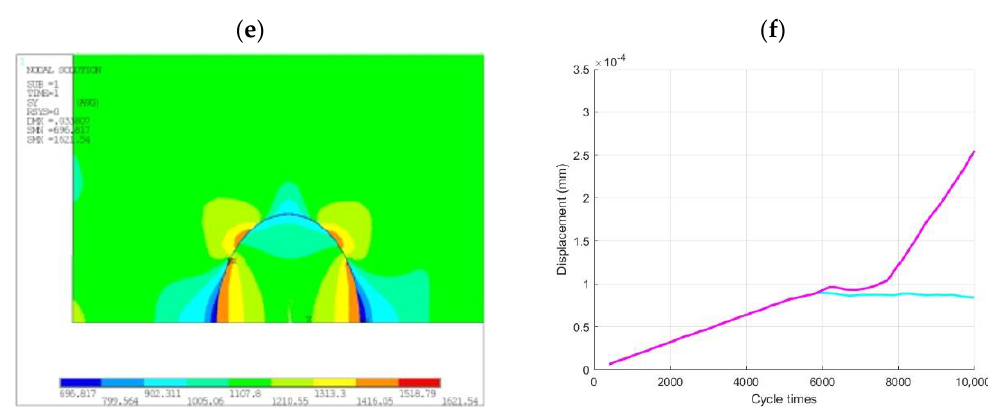
Figure 14. Effect of inclusion shape on interface debonding: ( a , b ) debonding stress and contact node displacement for c/a = 0.58. ( c , d ) Debonding stress and contact node displacement for c/a = 1. ( e , f ) Debonding stress and contact node displacement for c/a = 2.